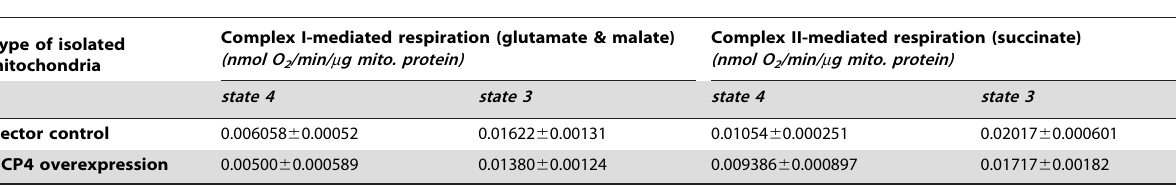
Table 1. Classical state 4 and state 3 respiration rate in UCP4-overexpressing and control mitochondria.